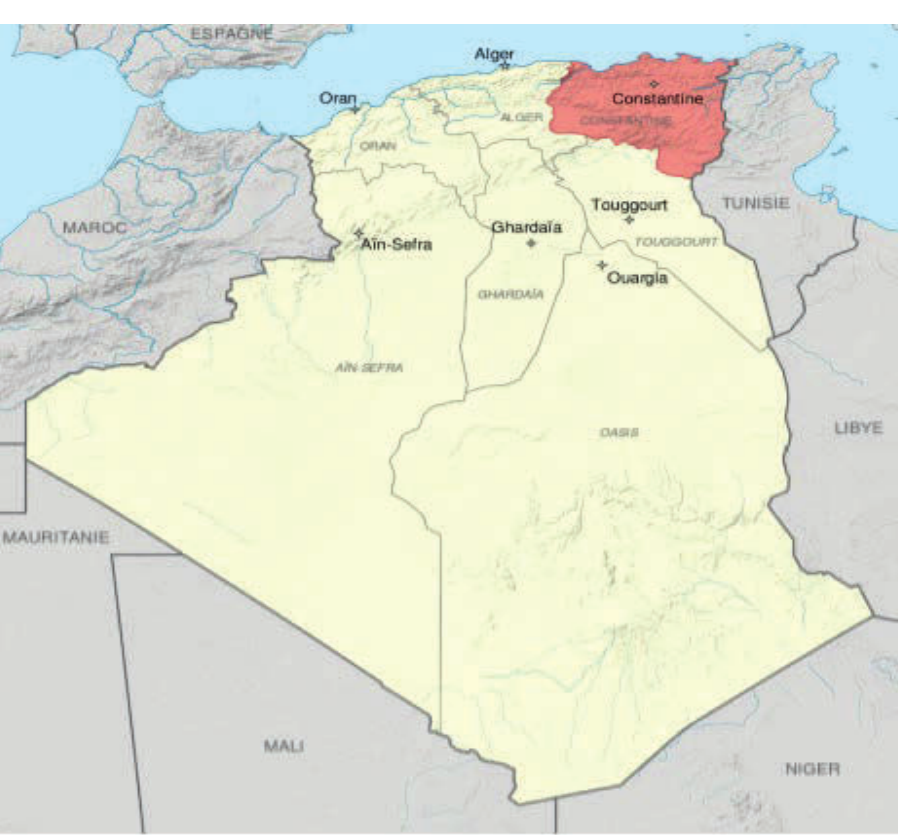
Fig. 2. Geographical position of Constantine (study area) in Algeria (Constantine map, n. d.).